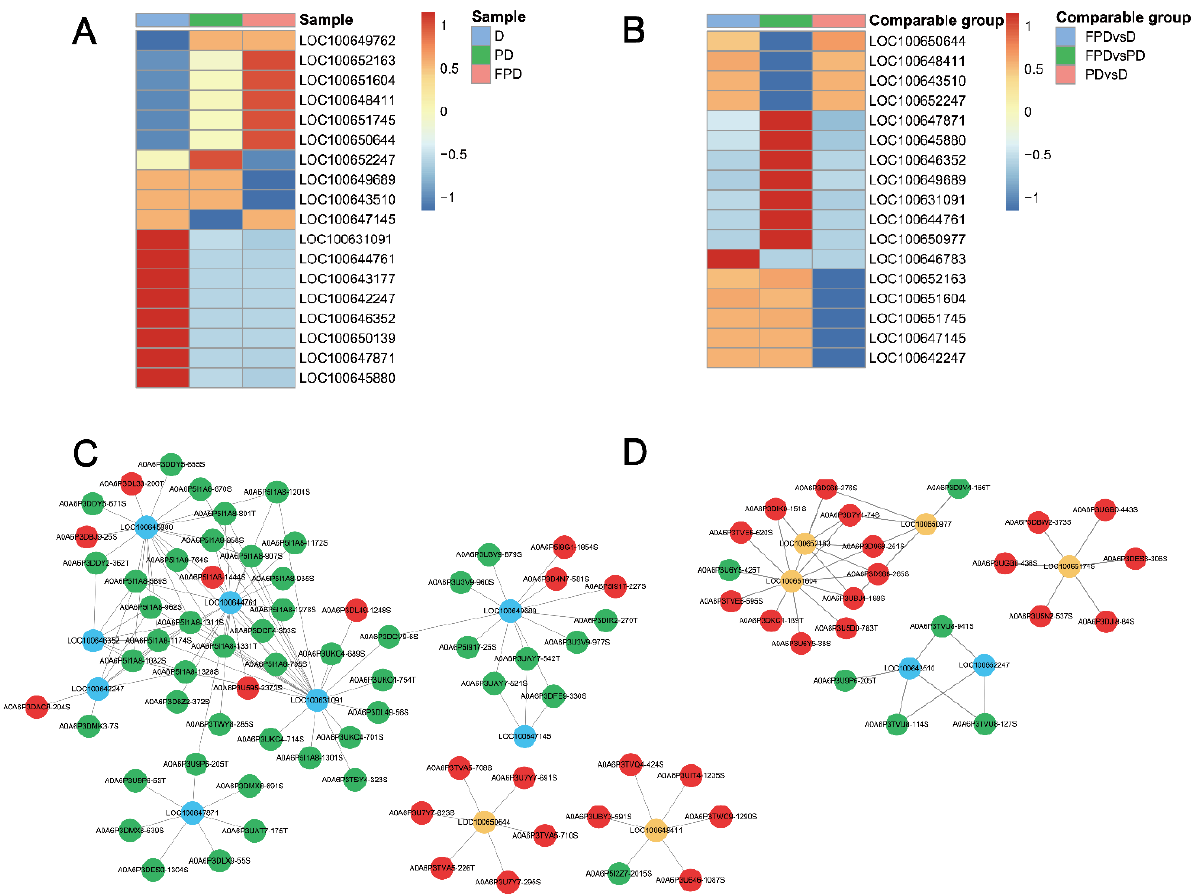
Figure 5. Changes in kinase activity and the kinase–substrate regulatory network in the different diapause stages of queens. ( A ) Kinase activity in D, PD, and FPD. Sample names in columns and phosphokinases in rows (rows are clustered and Z-score-normalized). ( B ) Kinase activity matrix heat map in comparable groups. Phosphokinases are listed in rows, and comparable groups are listed in columns s (rows are clustered and Z-score-normalized). The key kinase–substrate regulatory networks in ( C ) PD/D and ( D ) FPD/PD. Orange represents activated kinases, blue represents inhibited kinases, red represents upregulated phosphorylation sites, and green represents downregulated phosphorylation sites.